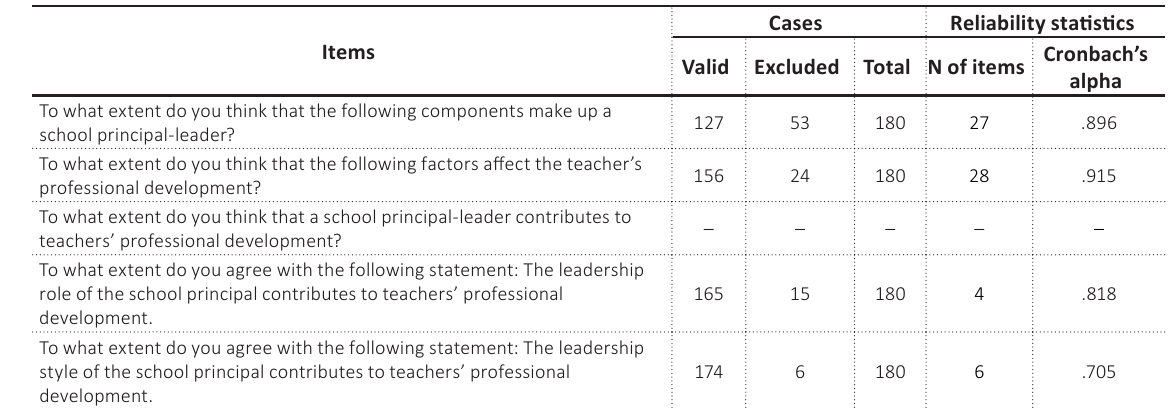
Table 2. Results of reliability analysis using Cronbach’s